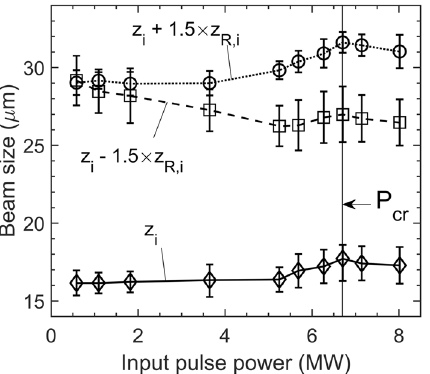
Figure 2. Imaged (far-field) beam size dependence on the input pulse power for deionized water at the three examined z-coordinates. In the far-field, a maximum divergence should correspond to a minimum beam